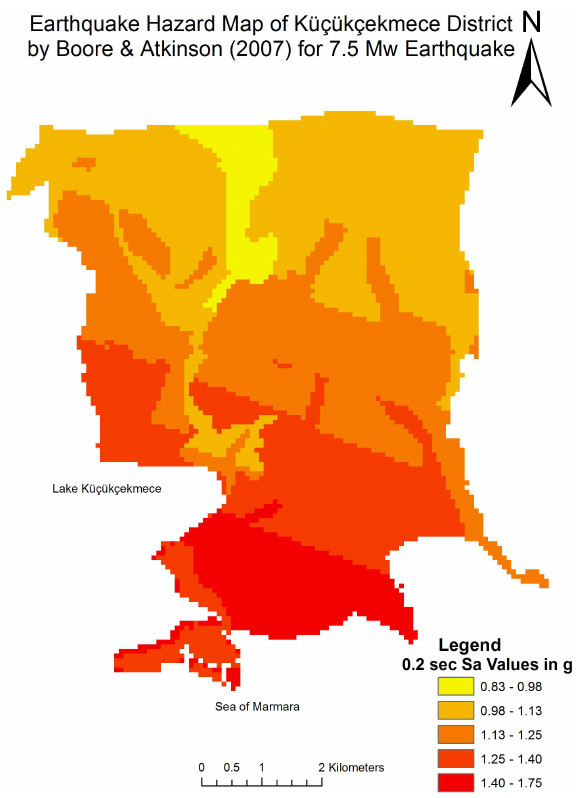
Fig. 6. A 0.2s Sa earthquake hazard map of Küçükçekmece District. Fig. 7. PGA earthquake hazard map of Küçükçekmece District.